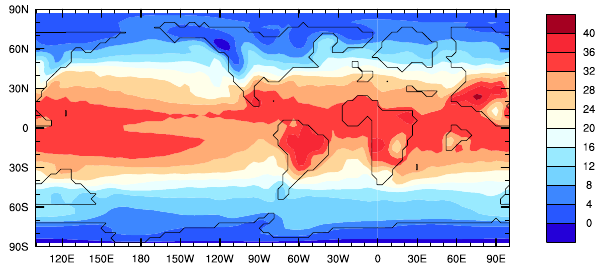
Figure 2. Forcing field: annual mean atmospheric temperature ( ◦ ) at 2m in Fig. 2. Forcing field: annual mean atmospheric temperature (°C) at 2 m height.